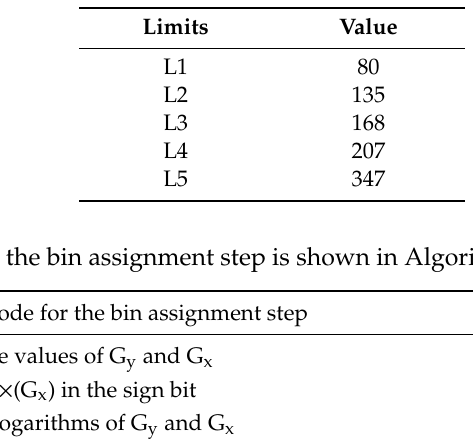
Table 1. Limits for bin assignment.